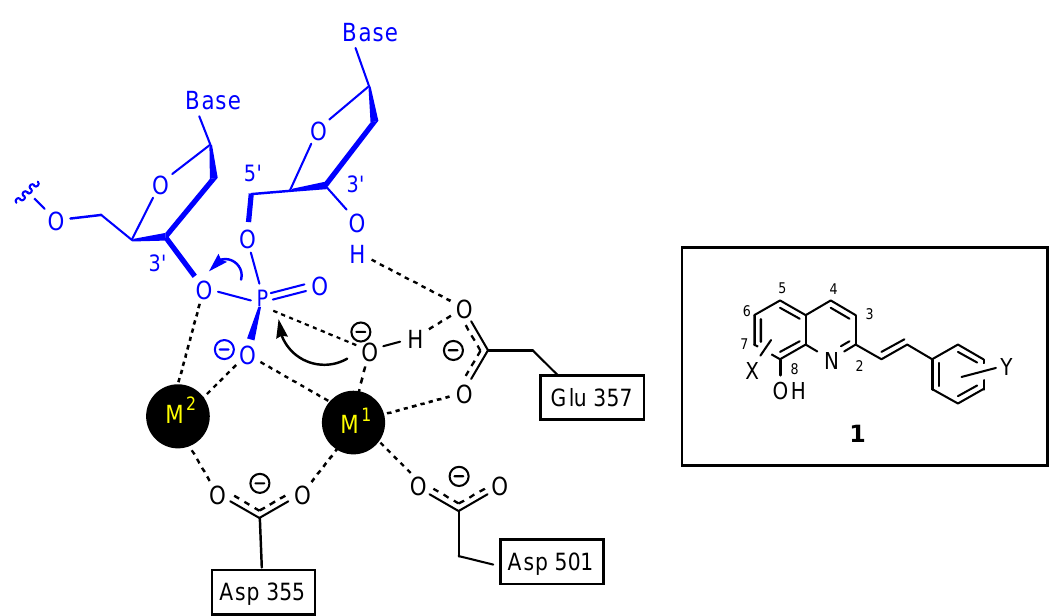
Figure 2. The “two-metal-ion” enzymatic mechanism for the 3'-5' exonuclease reaction of Escherichia coli DNA polymerase I according to the Beese and Steitz hypothesis [11] and general structure of styrylquinoline